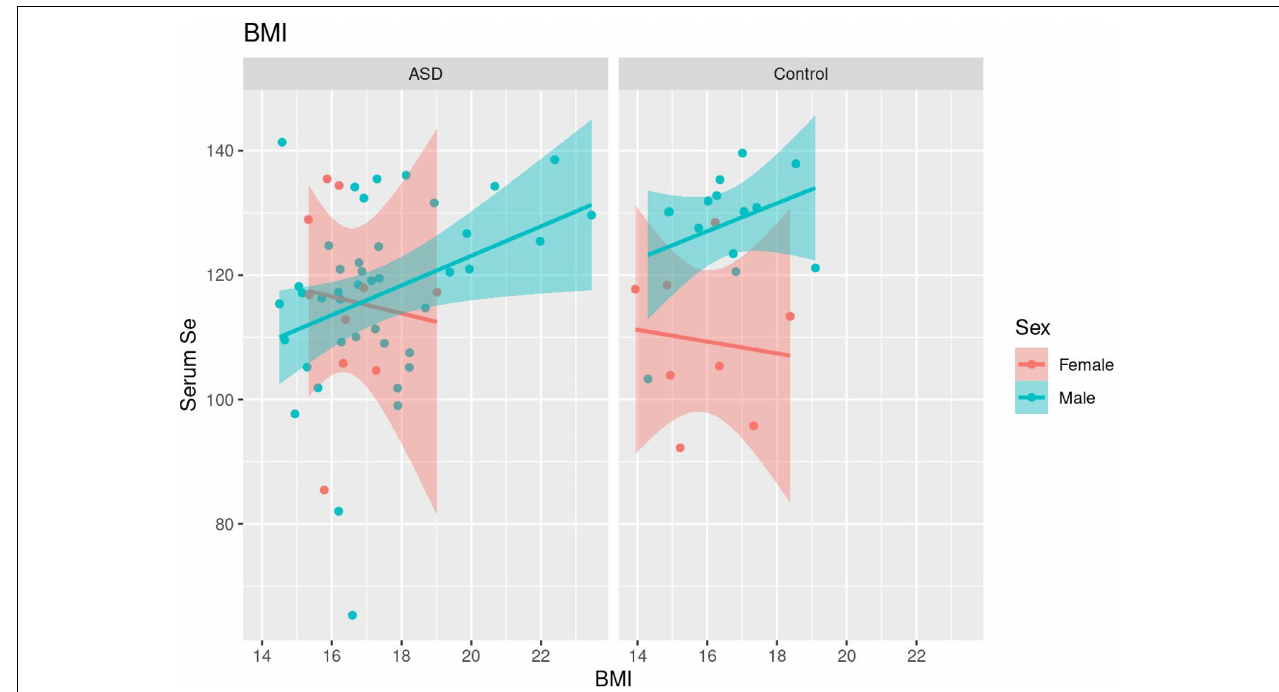
FIGURE 3 | Scatterplots of BMI and serum Se levels along with fitted linear trends, stratified by sex.